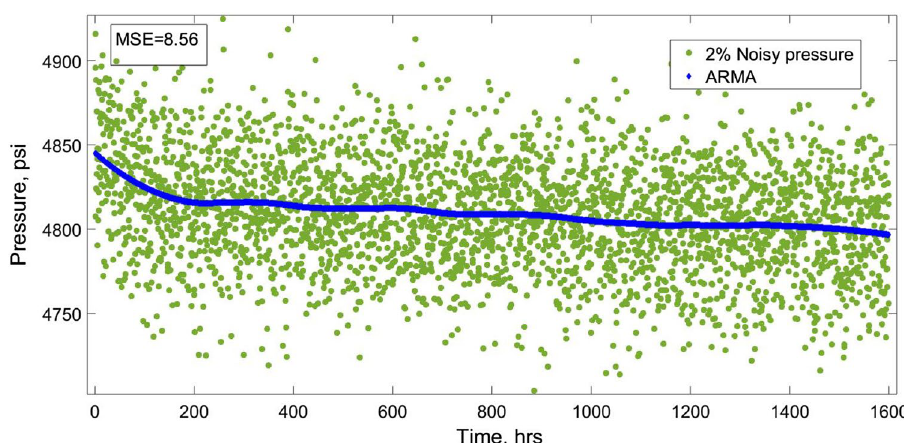
Fig. 4 Smoothed pressure data using the ARMA